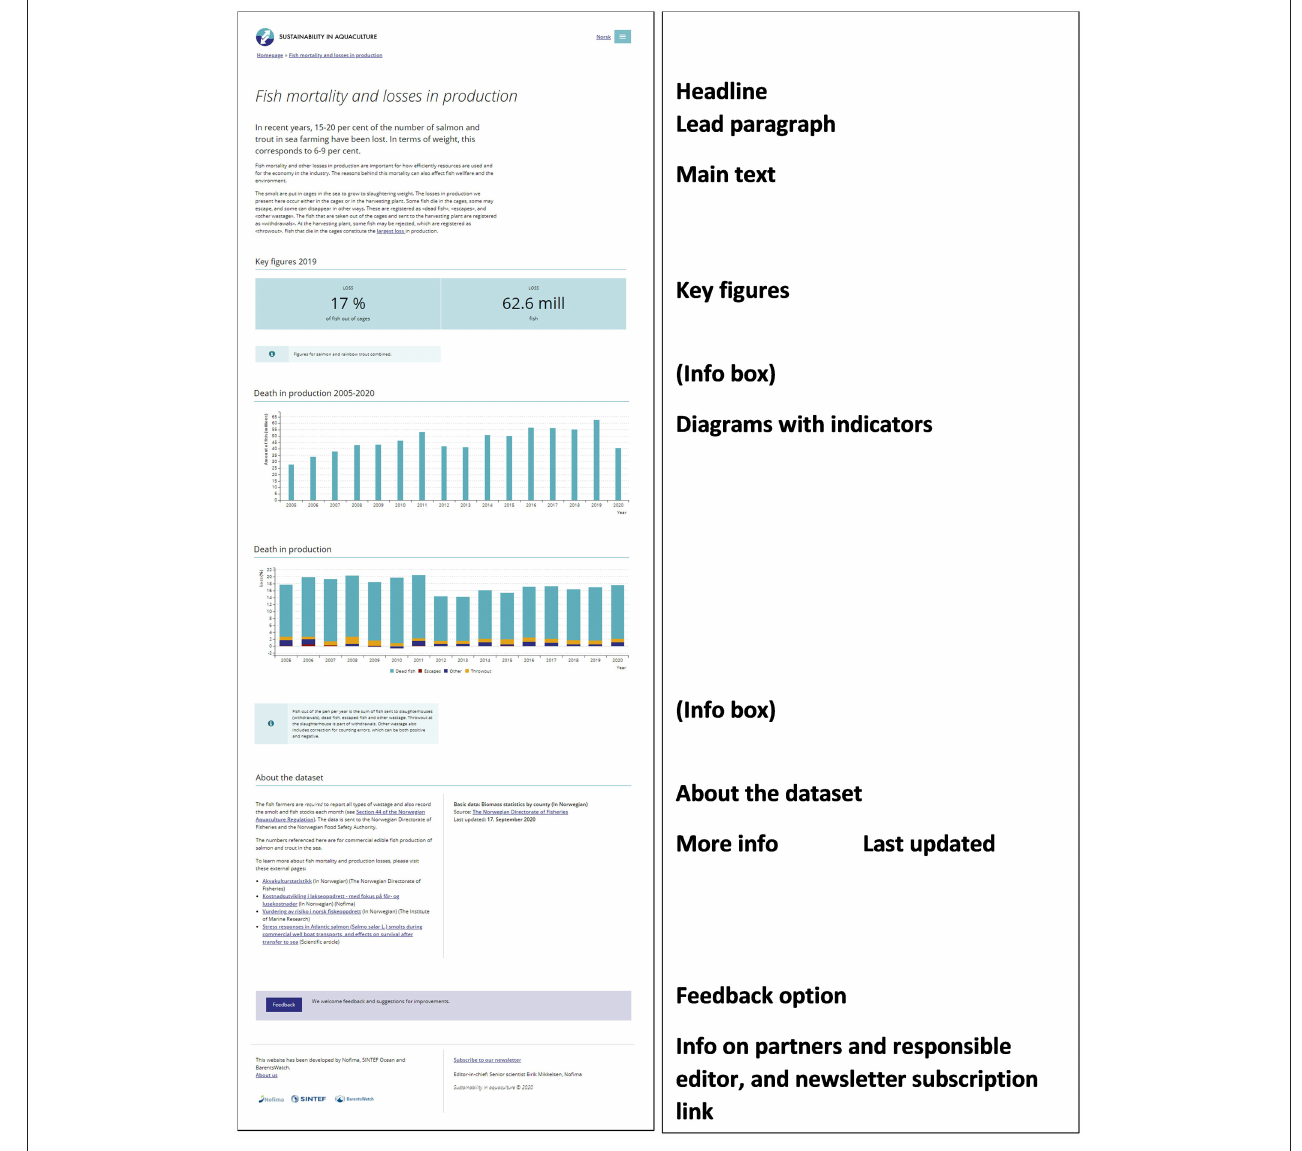
FIGURE 4 | Theme page